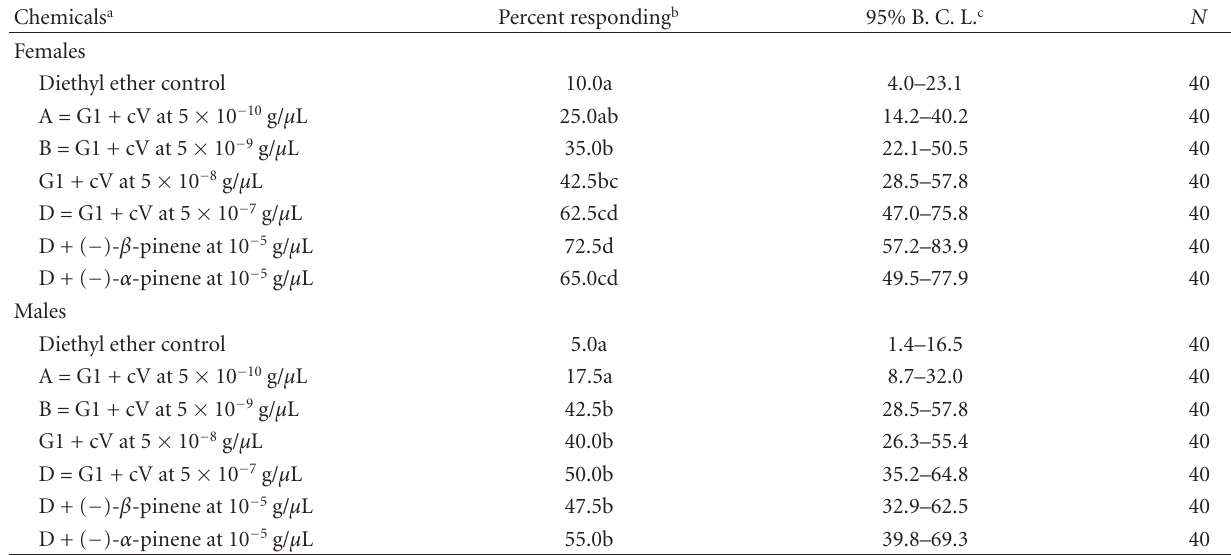
Table 3: Percent of walking Pityogenes bidentatus females and males responding in a laboratory olfactometer (21–23 May 2000) to conifer monoterpenes and its aggregation pheromone components (G1 = grandisol, cV = S - cis -verbenol).